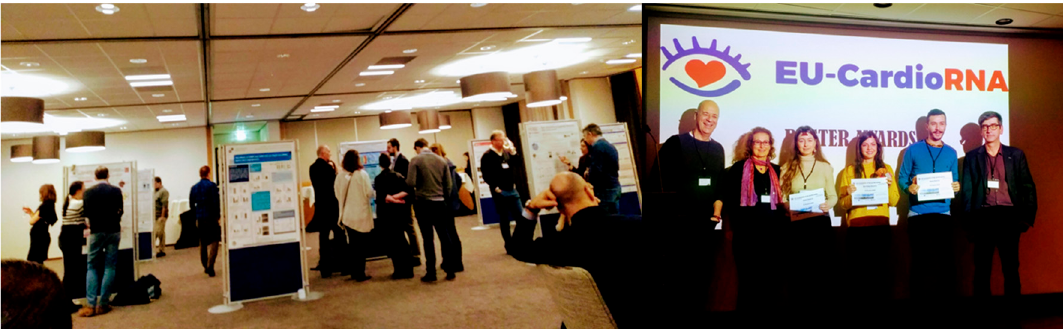
Figure 3. Photographs from the scientific poster session in Maastricht, 12 February 2020. Left: Lively discussion around the posters. Right: Poster prize winners with chairs of the three jury teams. Left-to-right: Thierry Pedrazzini (CH), Costanza Emanueli (UK), Teodora Barbalata (RO), Fabiana Martino (CZ), Francesco Ruberto (CH), Yvan Devaux (LU).